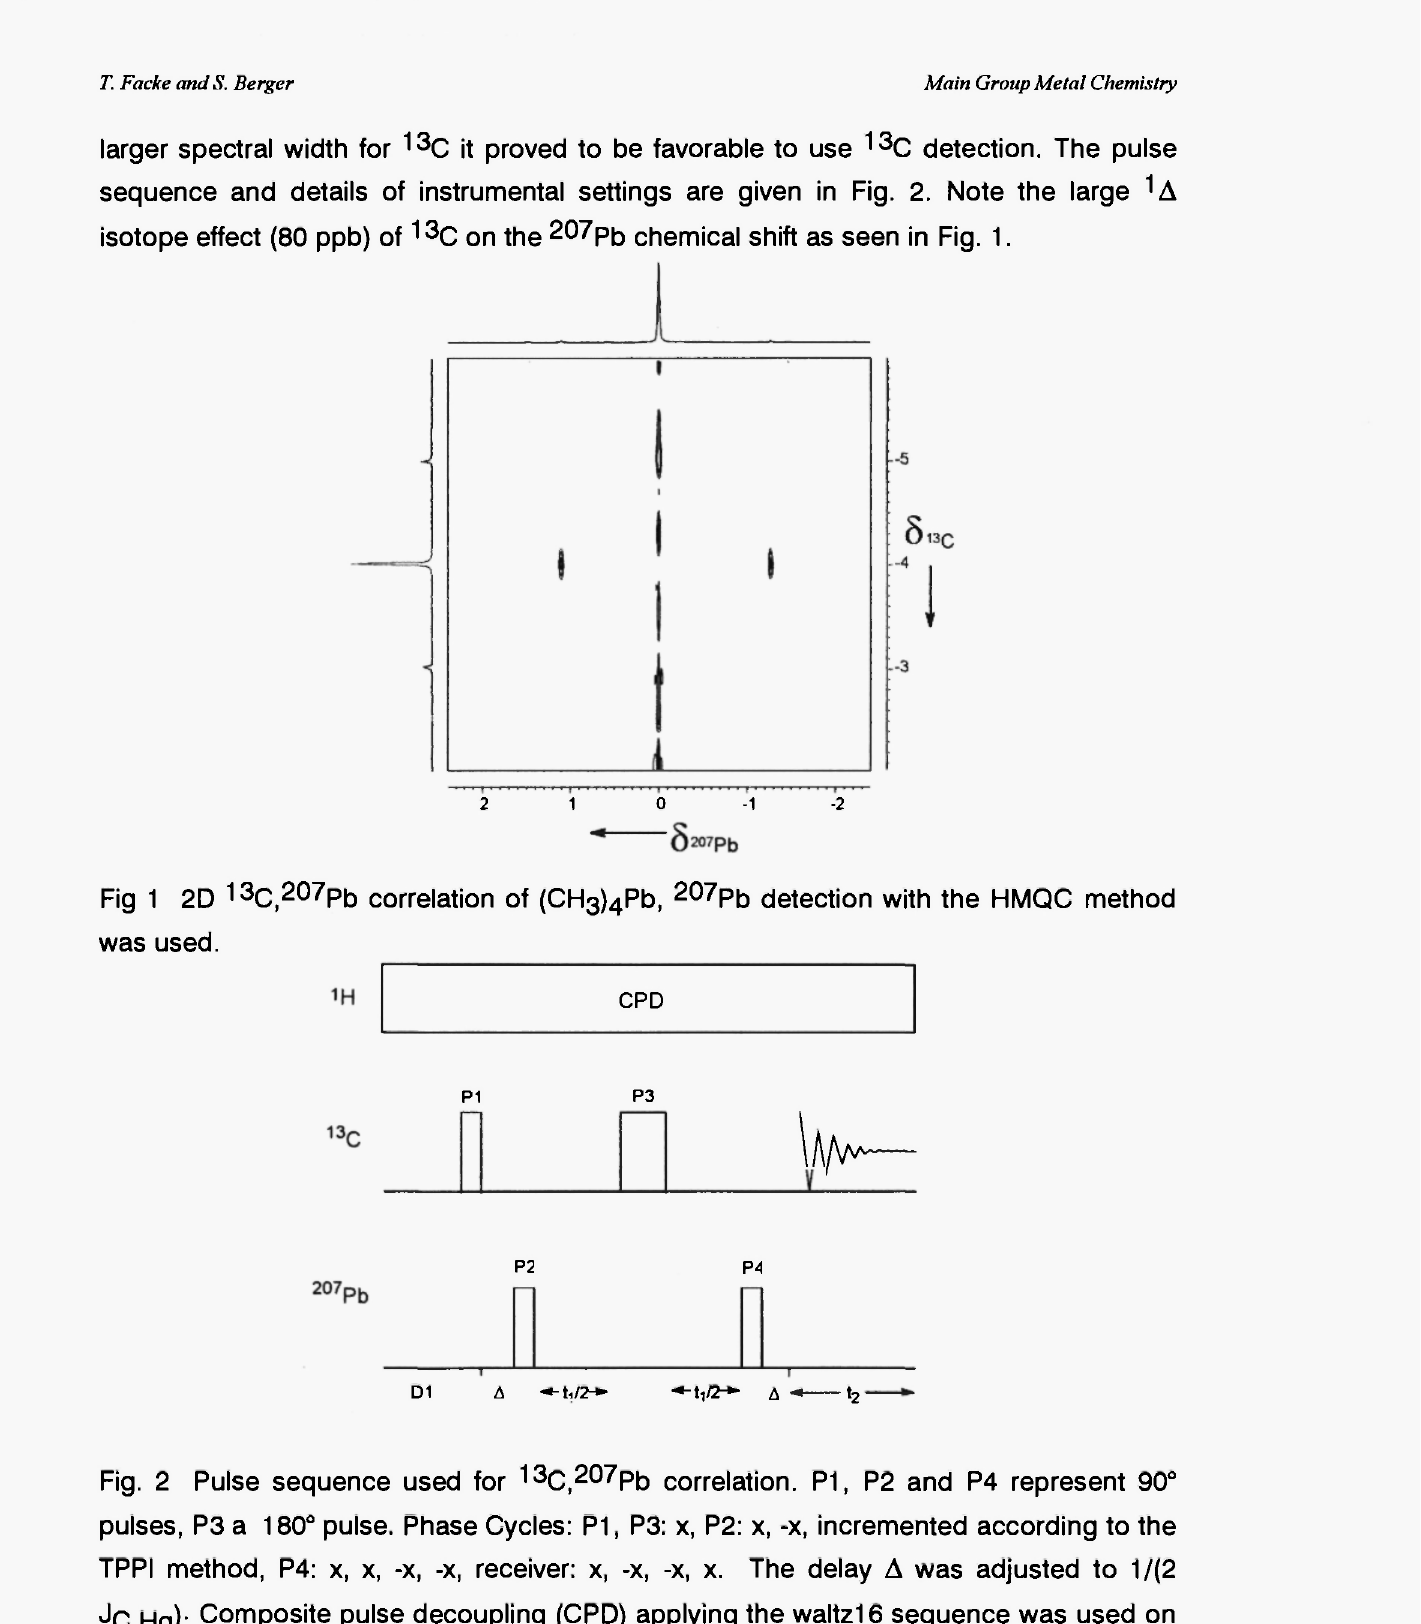
Fig. 2 Pulse sequence used for 13 C, 207 Pb correlation. P1, P2 and P4 represent 90° pulses, P3 a 180° pulse. Phase Cycles: P1, P3: χ, P2: x, -x, incremented according to